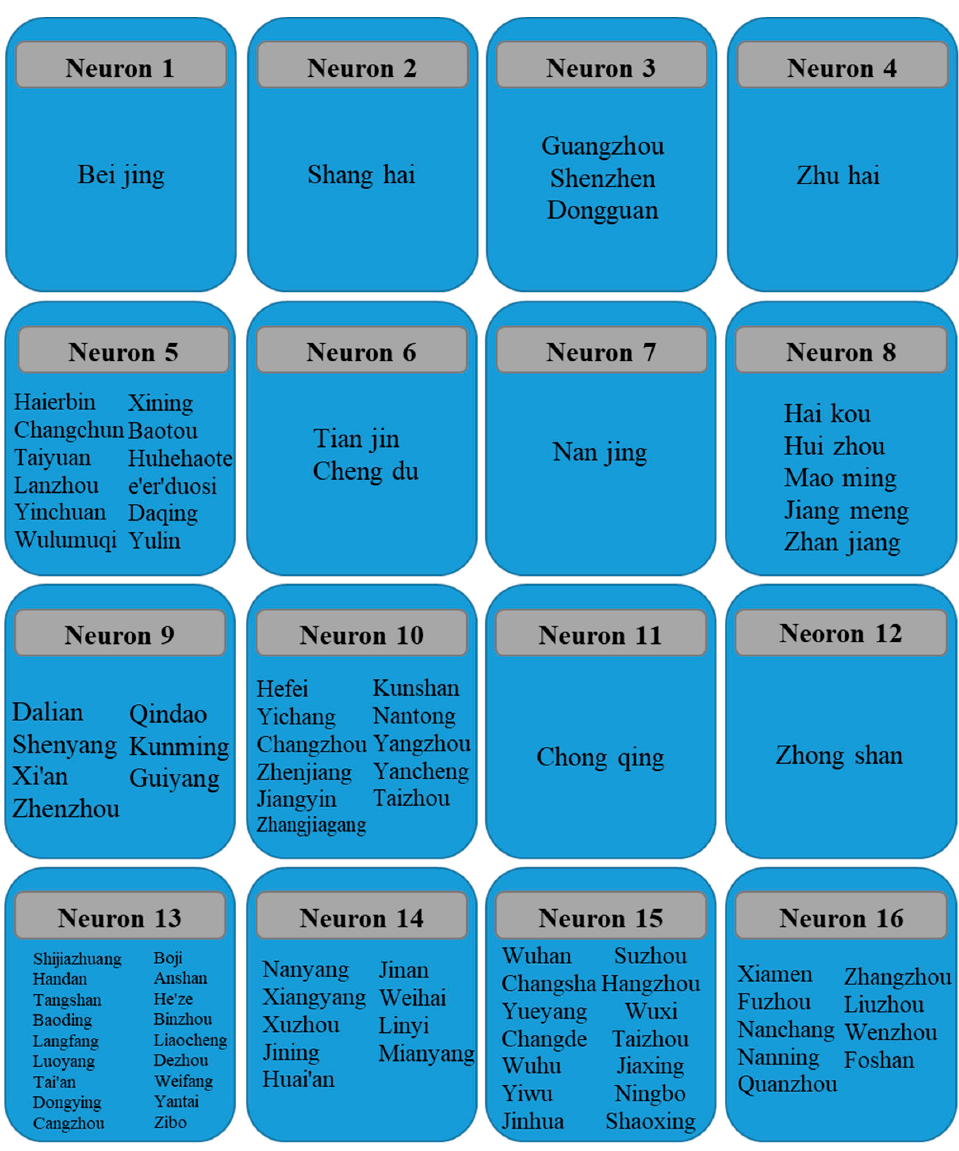
Figure 6. Result of SOM clustering.